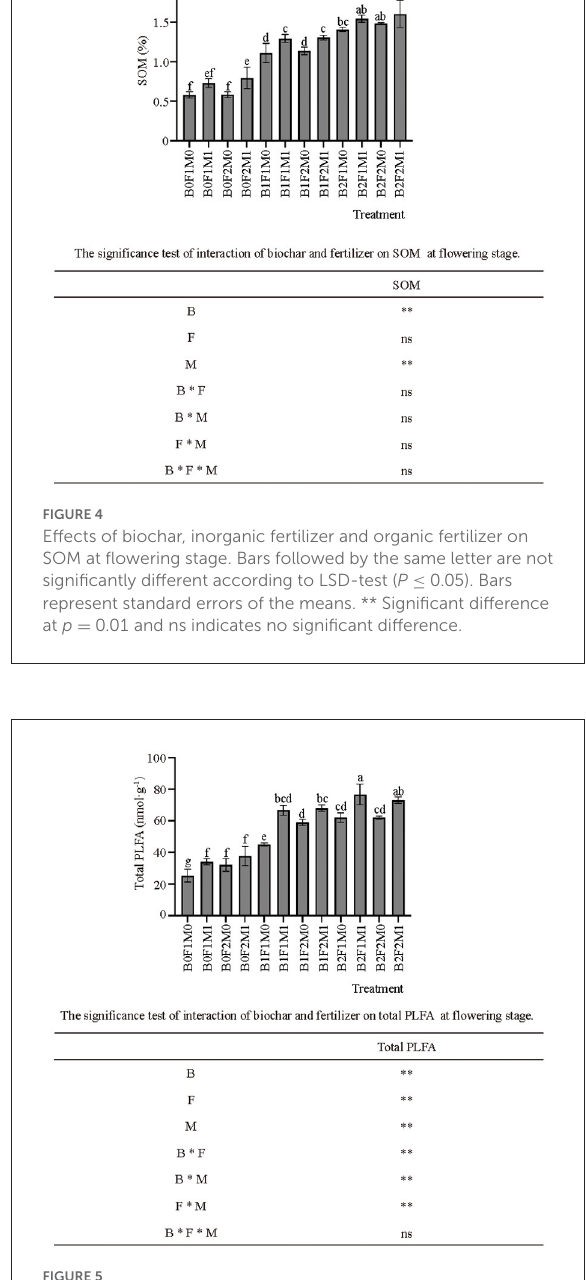
B0F1M1 was 25.86% higher than B0F1M0; B1F1M1 was 16.21% higher than B1F1M0; and B2F1M1 was 9.72% higher than